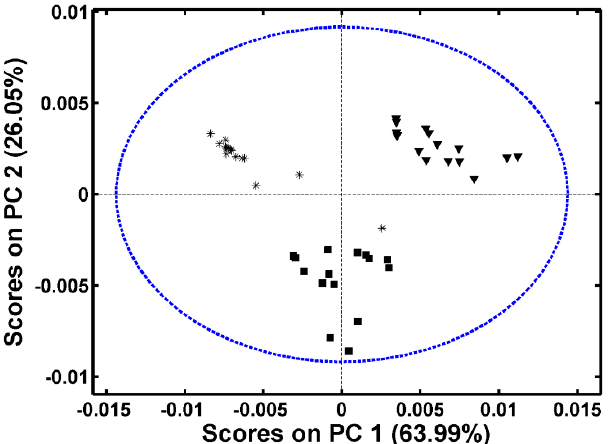
Figure 2. Plot of the scores of PC1 × PC2 of chicken frankfurter ( ■ ), turkey frankfurter ( ▼ ) and mixture meat frankfurter ( *